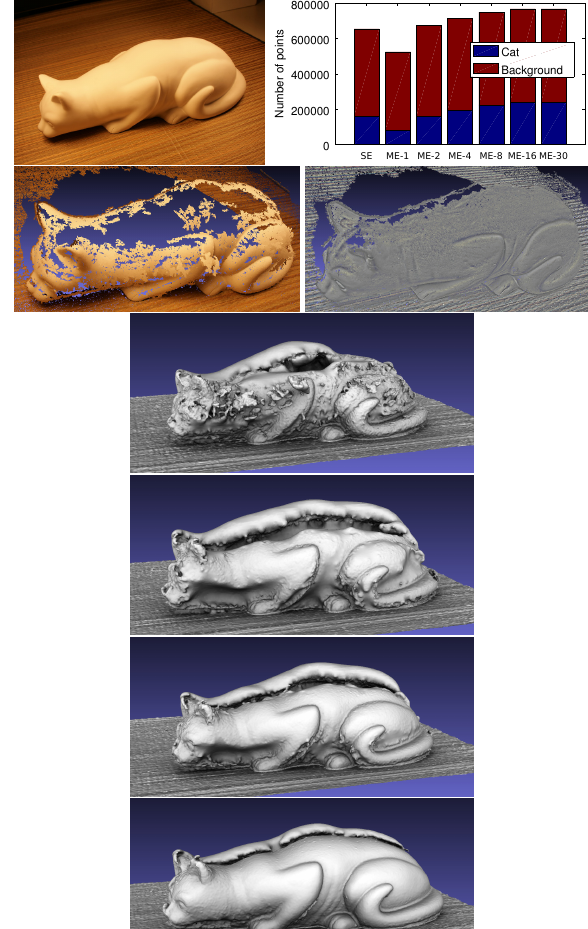
Figure 10. Cat dataset. Top to bottom, left to right: Example image, number of points in reconstruction, point cloud for SE, point cloud ME-30, mesh for SE, mesh for ME-1, mesh for ME- 2, and mesh for